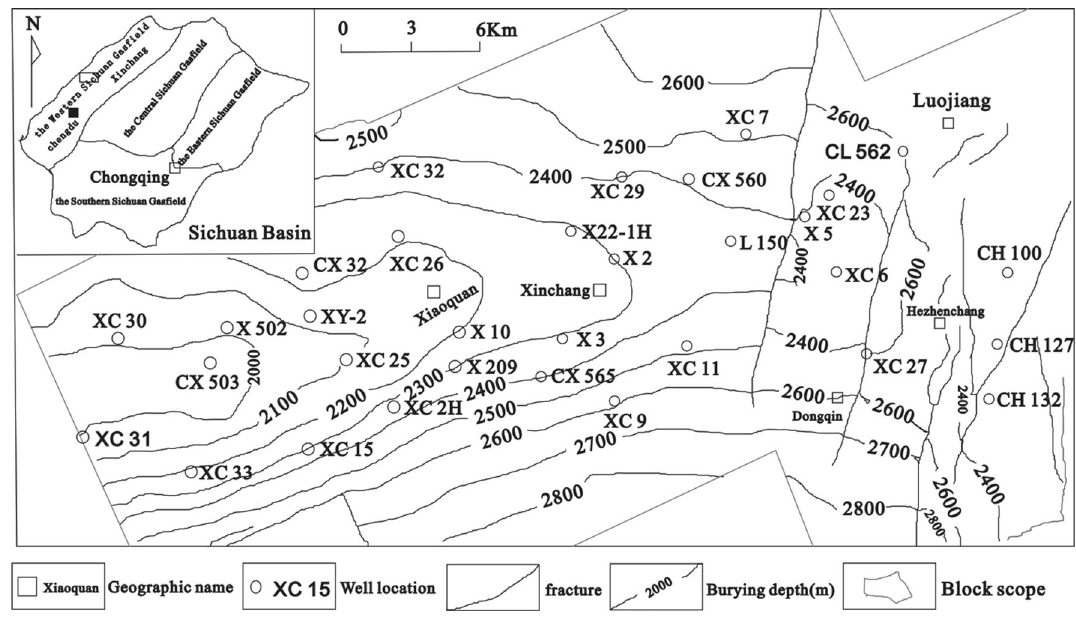
Figure 1. Study area and structural